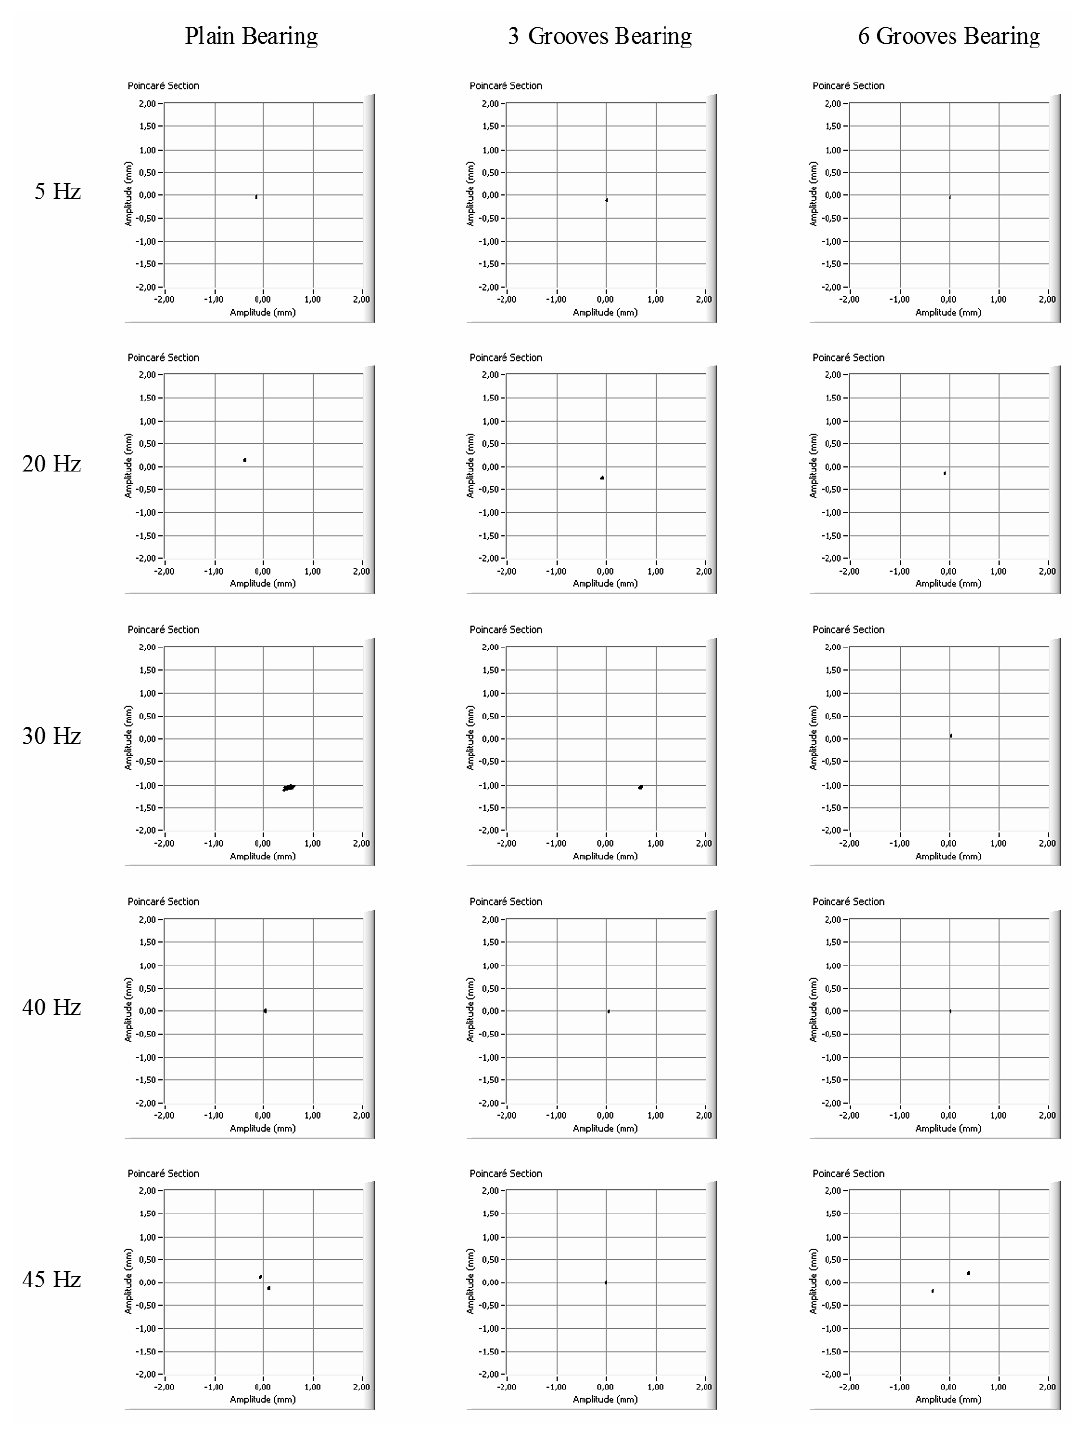
Fig. 13. Results – Poincar´e